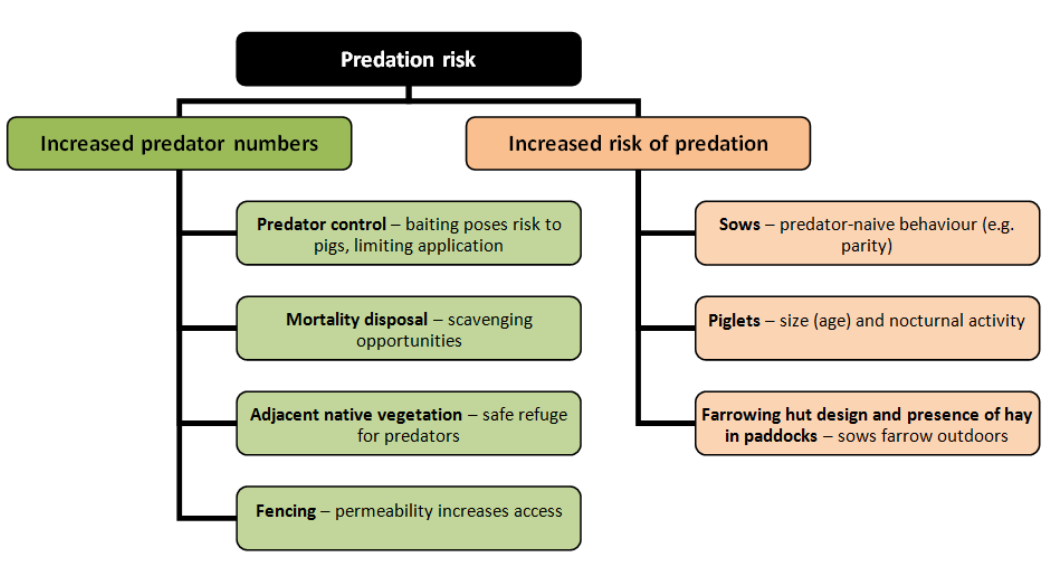
Figure 7. Summary of factors that lead to increased numbers of predators (e.g., red foxes) on outdoor piggeries and increased risk of fox predation.